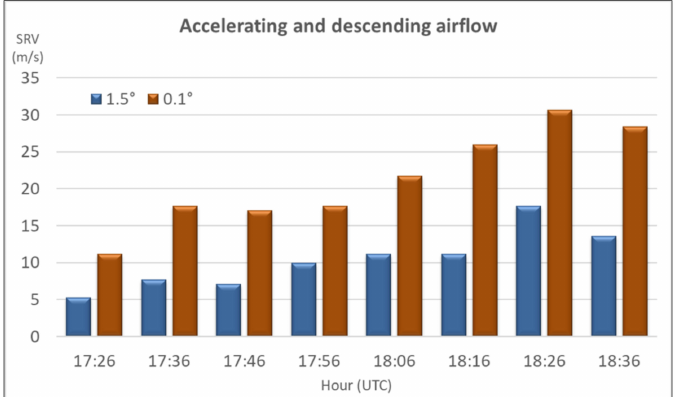
Figure 13. Maximum inbound storm velocity at the 1.5 ◦ and 0.1 ◦ tilts, 17:26–18:36 UTC, 17 June 2017, C/CL